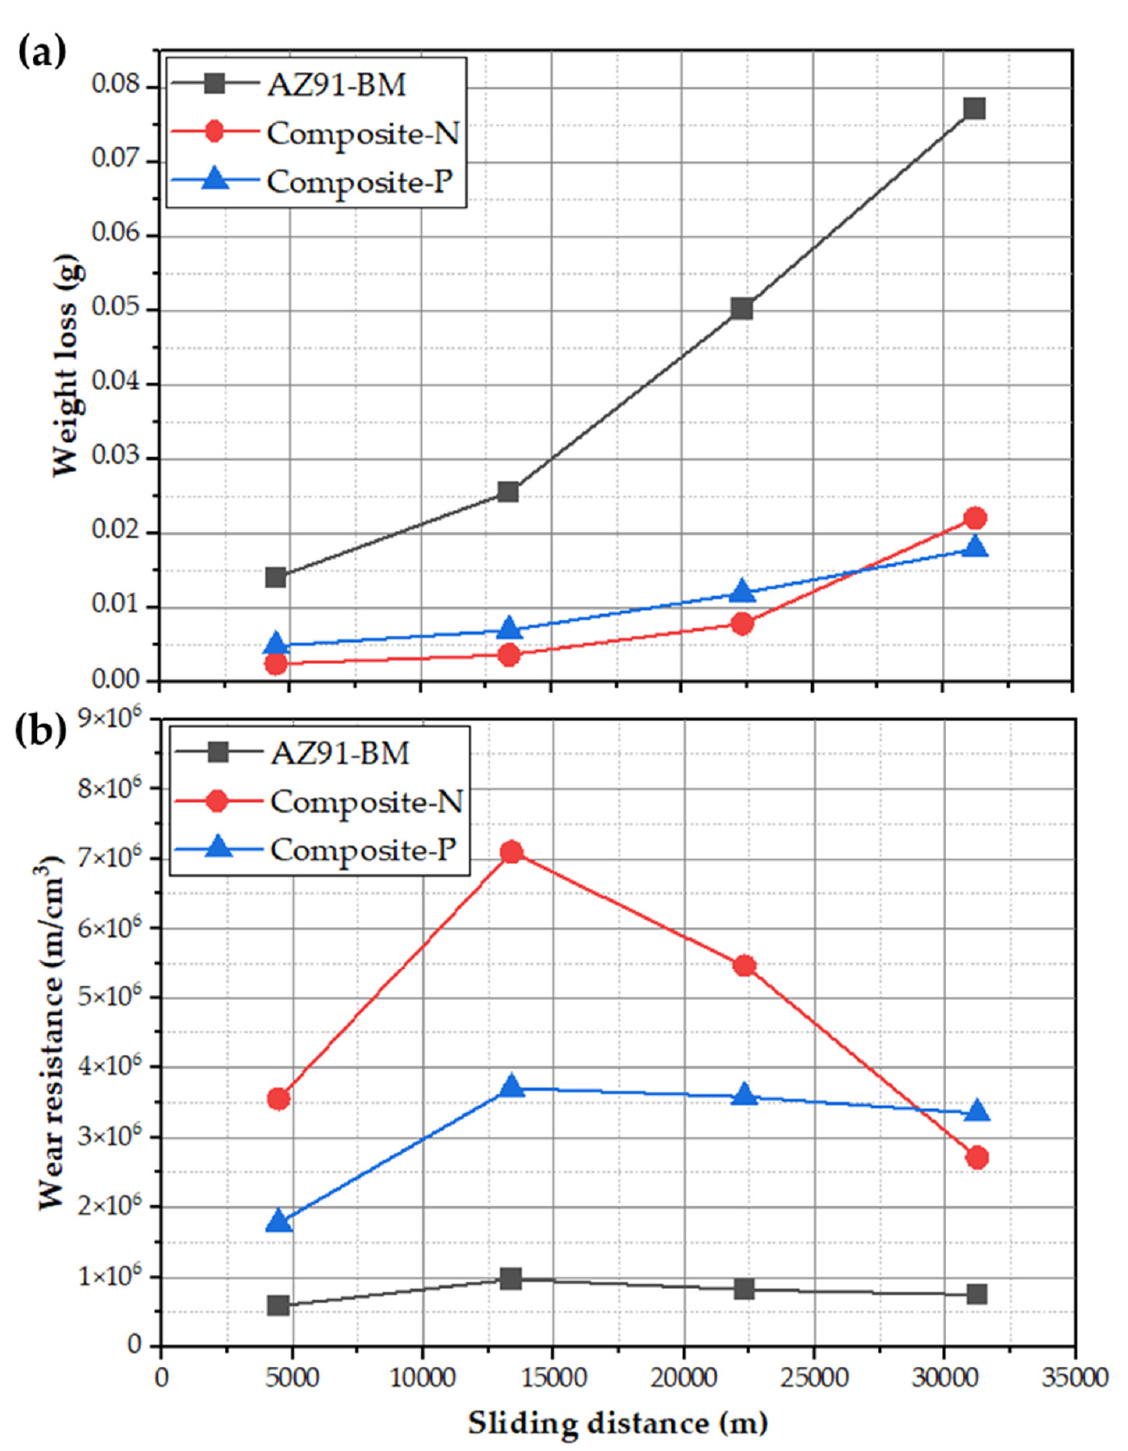
Figure 7. ( a ) Weight loss and ( b ) wear resistance against the applied sliding distances for AZ91-BM and composite specimens wear-tested at a constant wear load of 2 N.